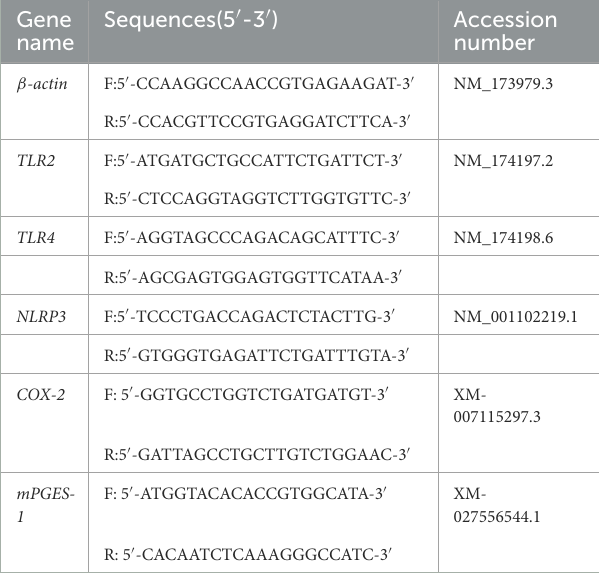
TABLE 2 Primer sequences for